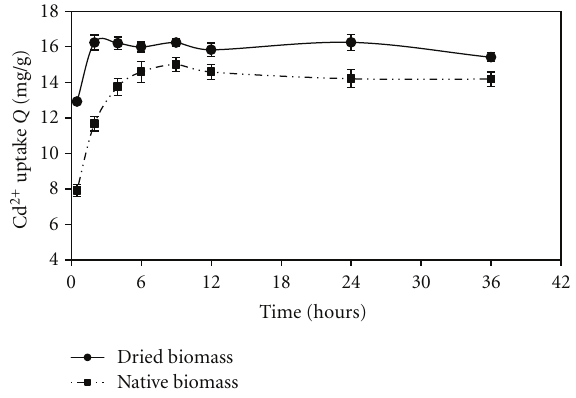
Figure 2: Time-dependency profile of Cd(II) uptakes by native and dried biomassat initial concentration of 10ppm; temperature 25 ◦ C; pH